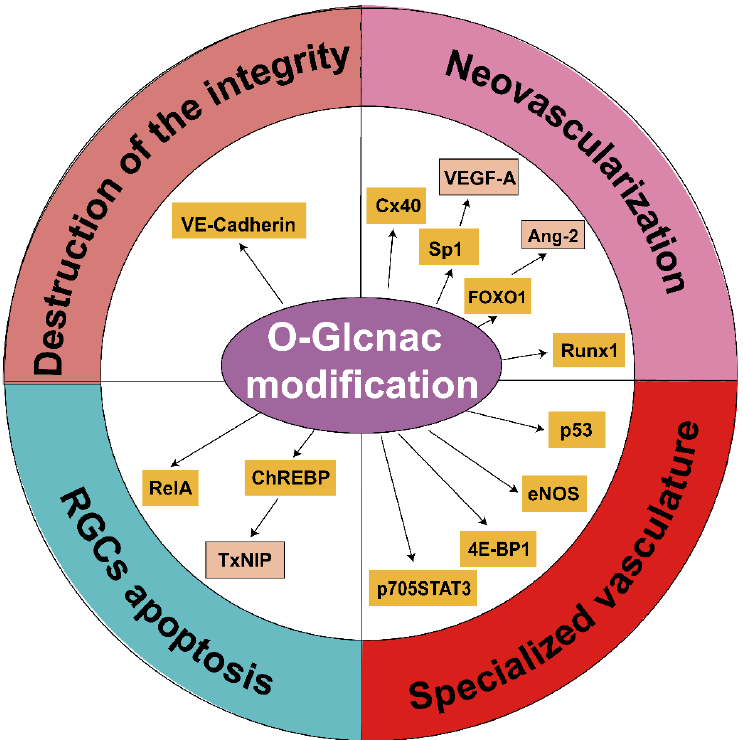
Figure 4. O -GlcNAc modification and related biological mechanisms in DR. Many proteins, including transcriptional factors, enzymes, and structural proteins, can be modified via O -GlcNAc modification and participate in DR. Abbreviations: OGT, β -N-acetylglucosaminyltransferase; VE-cadherin, vascular endothelial cadherin; Sp1, transcription factor specificity protein 1; VEGF-A, vascular endothelial growth factor-A; Runx1, runt-related transcription factor 1; cx40, connexin40; FoxO, Forkhead box O; Ang-2, angiopoietin 2; eNOS, endothelial nitric oxide synthase; 4E-BP1, eukaryotic translation initiation factor 4E-binding protein 1; STAT3, signal transducer and activator of transcription 3; ChREBP, carbohydrate-responsive element-binding protein; TXNIP, thioredoxin-interacting protein; RelA, nuclear factor kappa B p65; RGC, retinal ganglion cell.